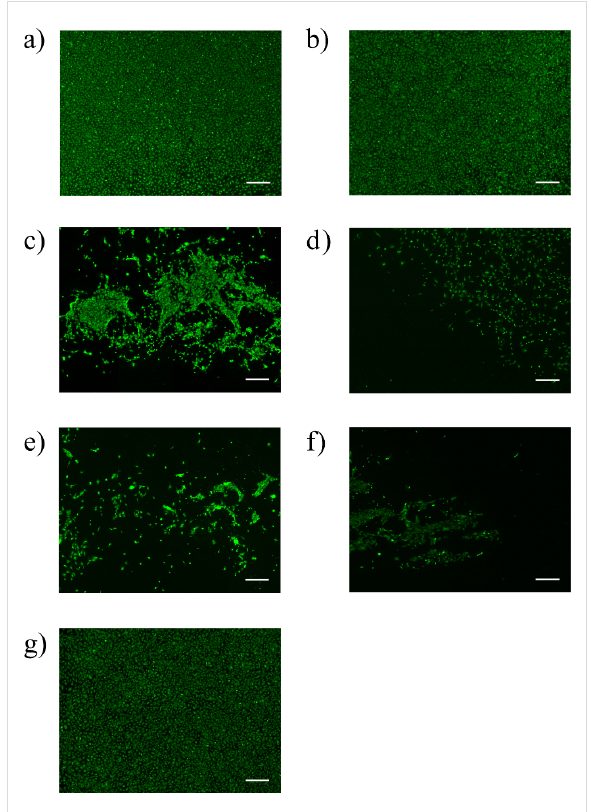
Figure 5: Cell seeding onto TPX derivatives (scale bar equals 500 µm) (a) 2 as control with heparin/albumin dip coating; (b) 2 treated with forming-gas plasma; (c) functionalized TPX 4 with PEG; (d) functional- ized TPX 7a with PEG and alkyne group; (e) functionalized TPX 8a with c RGD (copper-catalyzed approach); (f) functionalized TPX 7b with PEG and oxanorbonadiene group; (g) functionalized TPX 8b with c RGD (copper-free